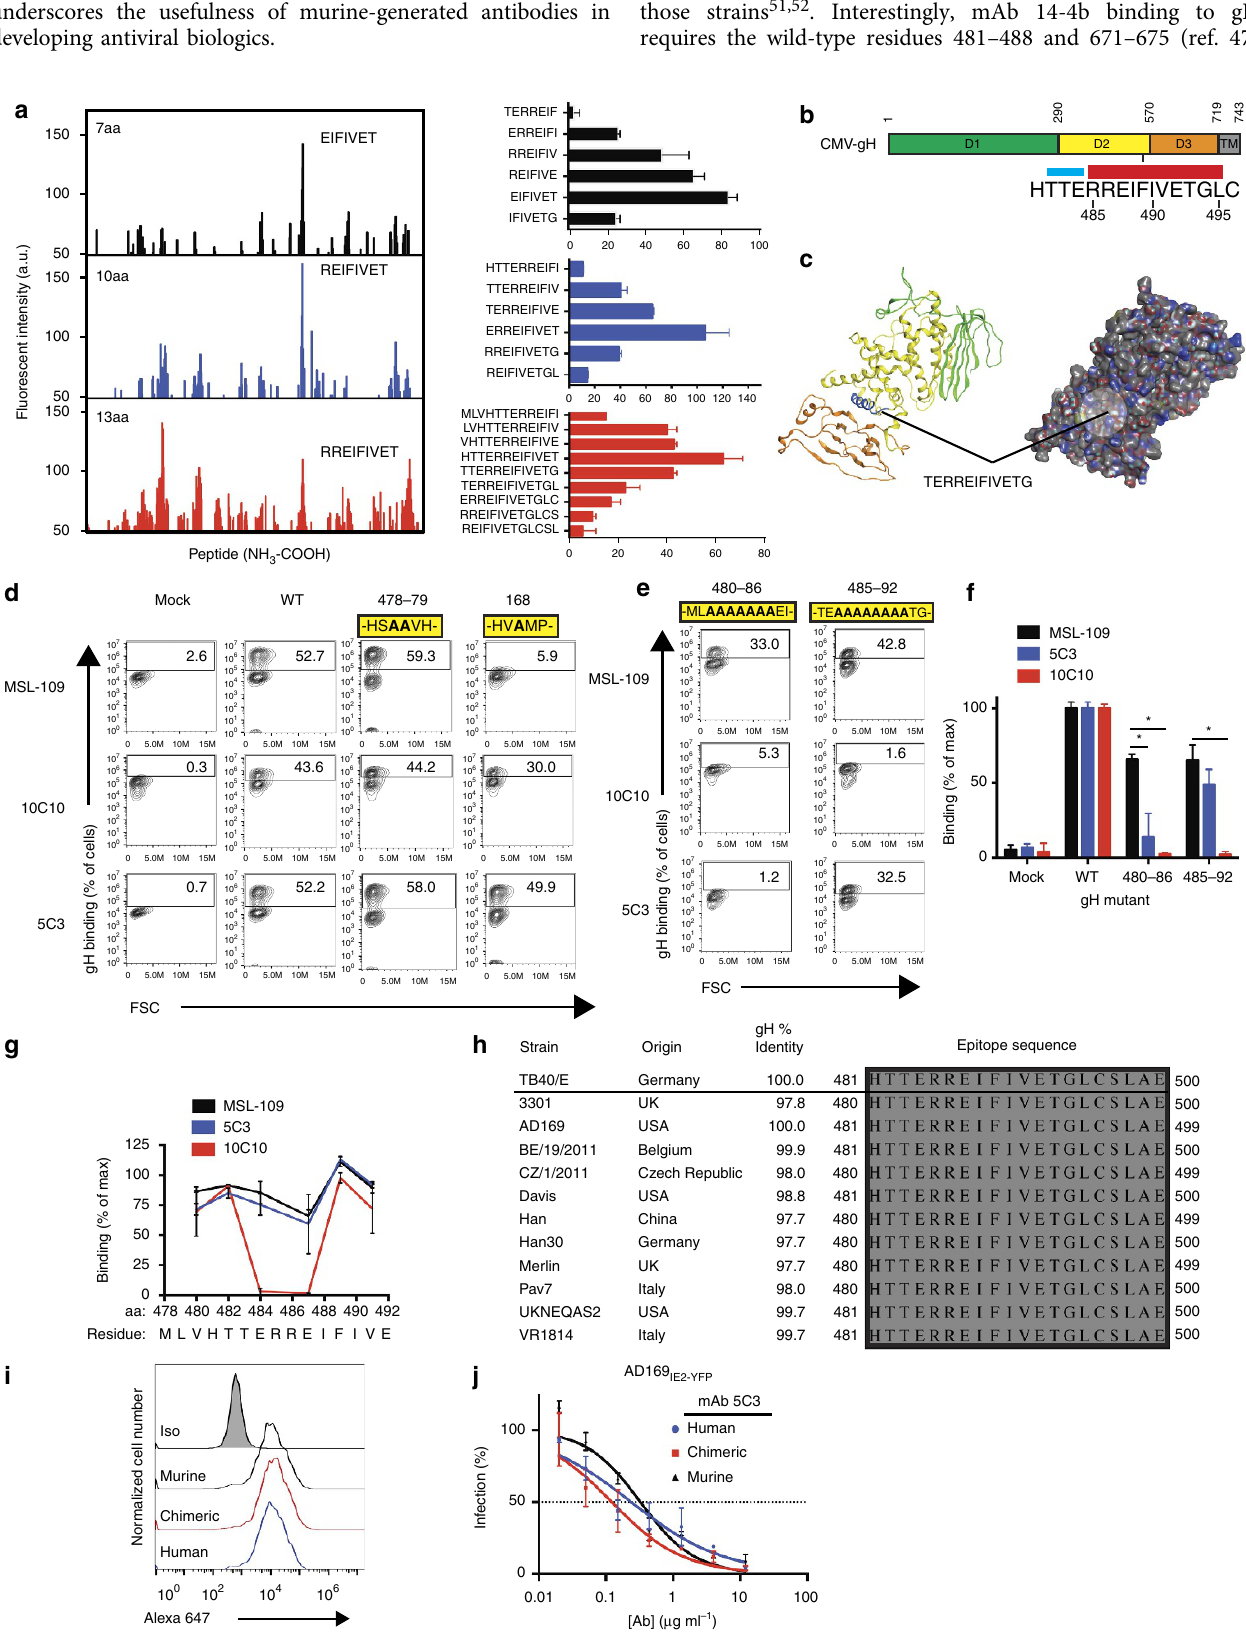
HTTERREIFI TTERREIFIV TERREIFIVE ERREIFIVET RREIFIVETG REIFIVETGL MLVHTTERREIFI LVHTTERREIFIV VHTTERREIFIVE HTTERREIFIVET TTERREIFIVETG TERREIFIVETGL ERREIFIVETGLC RREIFIVETGLCS